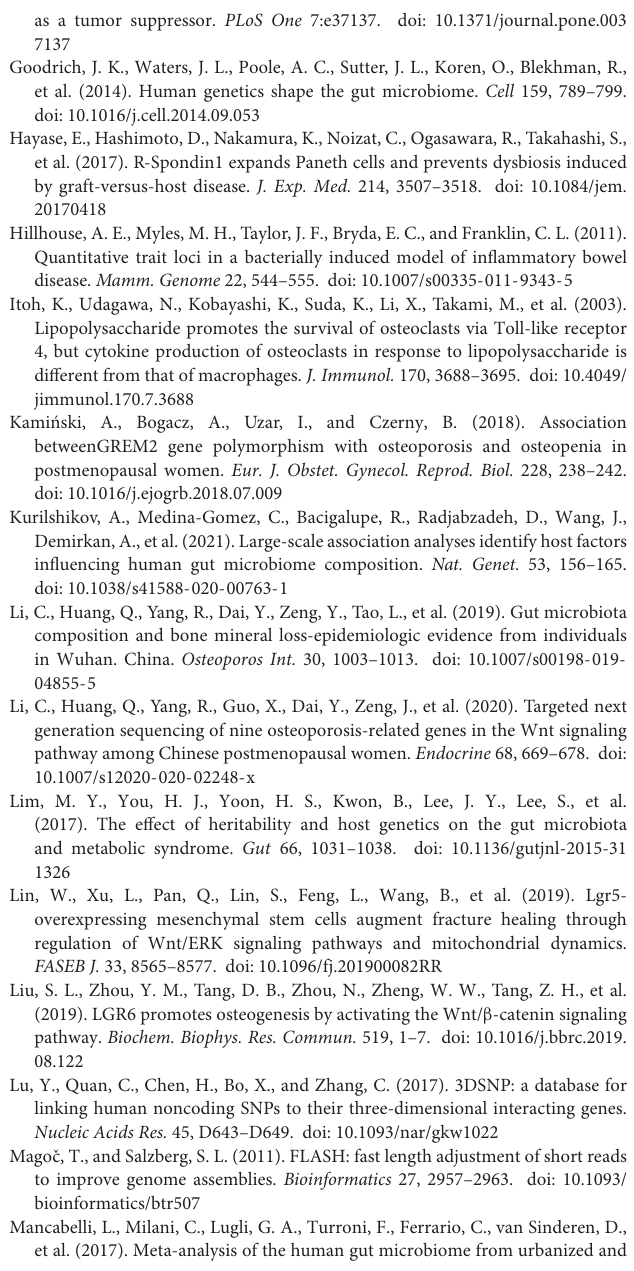
Supplementary Figure 4 | LEfSe indicating differences in the bacterial taxa at different levels (p, phylum; c, class; o, order; f, family; g, genus; and s, species). Only the taxes having a P < 0.05, and LDA value > 2 are shown in the figure. Supplementary Table 1 | Results of multiple linear regression analysis of the effects of the two top common variants on BMD measurements. Supplementary Table 2 | The HaploReg v4.1 predictions for the proxies of genetic variants rs11178860 and rs10920362. Supplementary Table 3 | Results of SNPinfo predictions for the proxies of genetic variants rs11178860 and rs10920362.